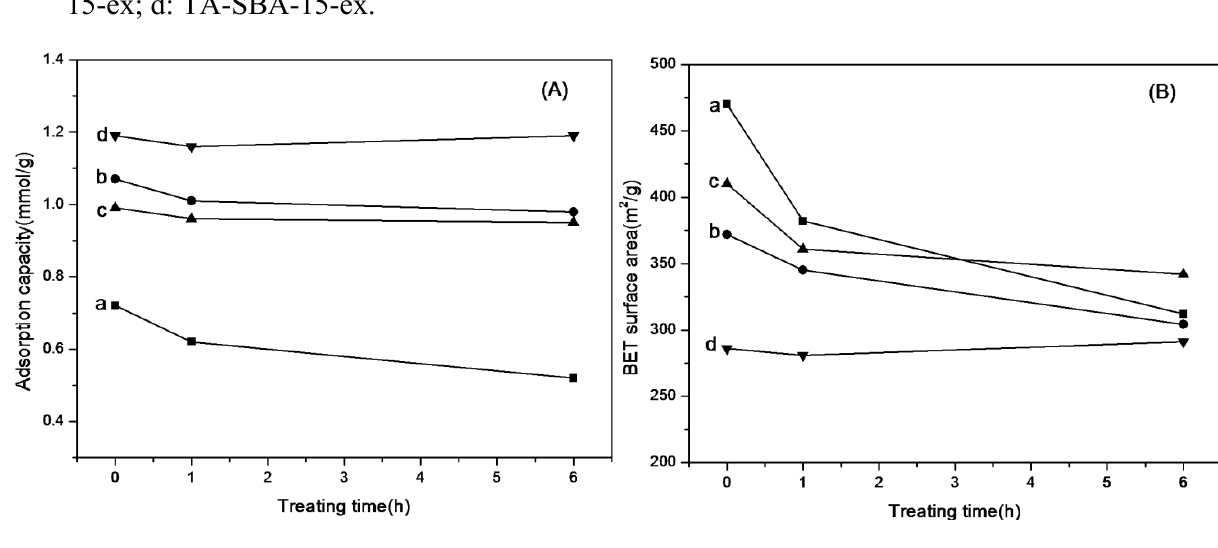
Figure 10. Comparison of ( A ) adsorption capacity; ( B ) Brunauer–Emmett–Teller (BET) surface area; ( C ) total pore volume; and ( D ) N contents of amine-grafted SBA-15 before and after steam treatment. a: APTMS-SBA-15-c; b: APTMS-SBA-15-ex; c: AEAPS-SBA- 15-ex; d: